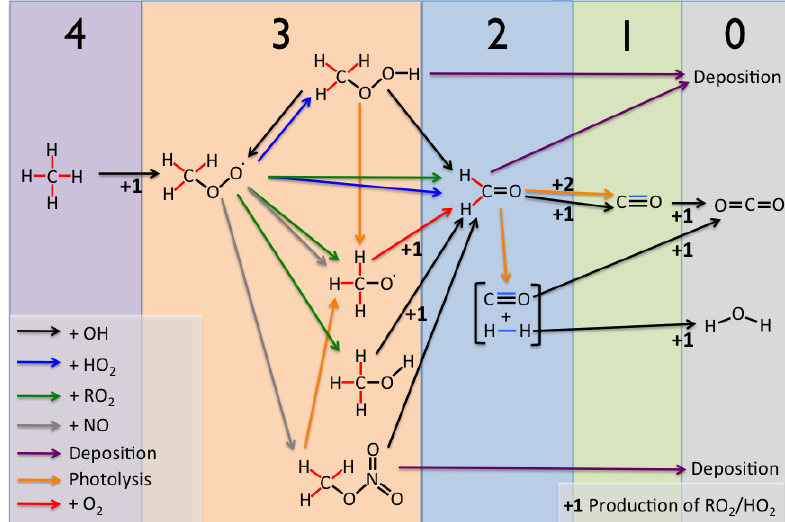
Figure 1. Peroxy radical production during the tropospheric oxidation of CH 4 . Moving from left to right, the oxidisable bonds (emitted: red; produced: blue) present in CH 4 are removed via a range of tropospheric processes, indicated by the coloured arrows. The large numbers across the top of the figure indicate the number of oxidisable bonds at each stage of this oxidation. The production of RO 2 is indicated by the + 1 / + 2 numbers with the associated process arrows for producing one or two RO 2